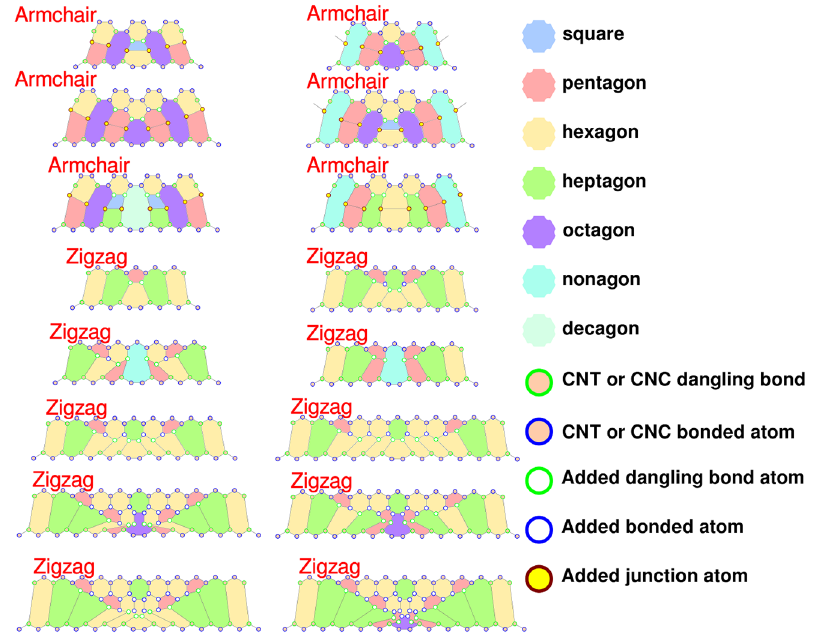
Figure 7. Auxiliary structures for armchair and zigzag carbon nanotubes.